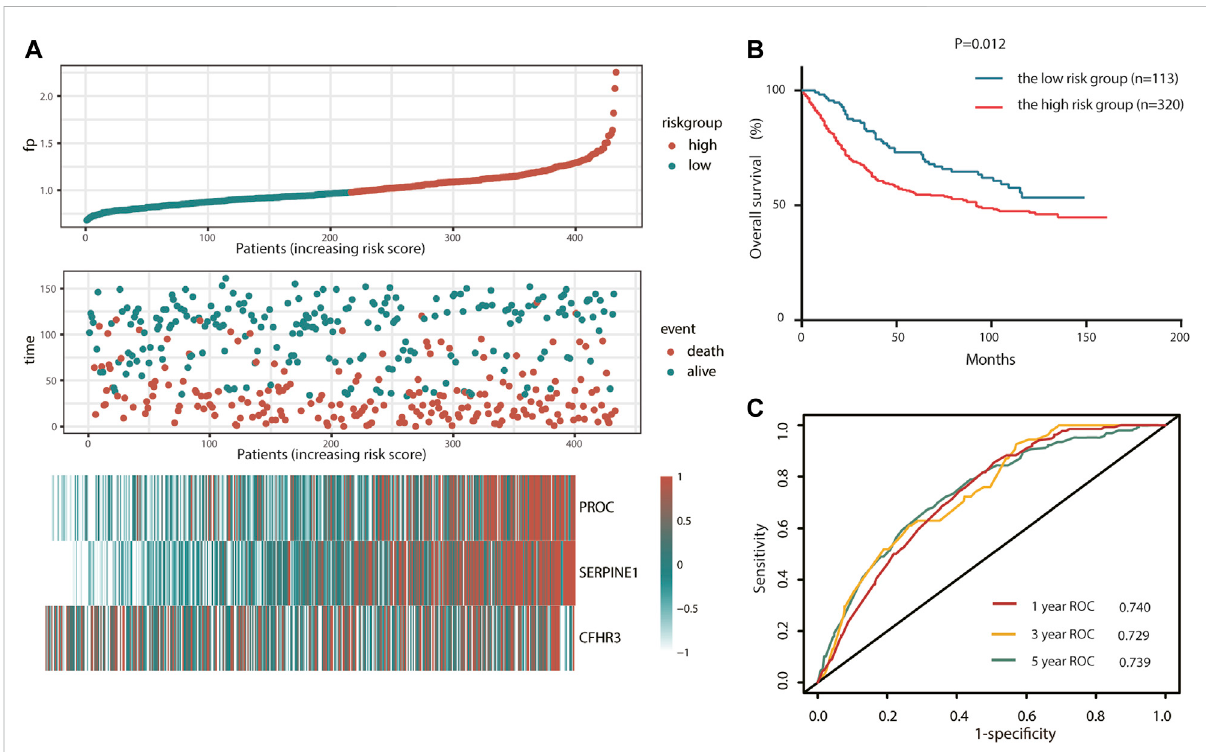
FIGURE 4 Validation of complement system-related three-gene signature in the GEO cohort. (A) Detailed risk scores, survival status of GEO STAD patients, and heatmap of three complement system-related genes in theGEO cohort. (B) K – M curves for the overall survival of patients in high- and low-risk groups. (C) ROC